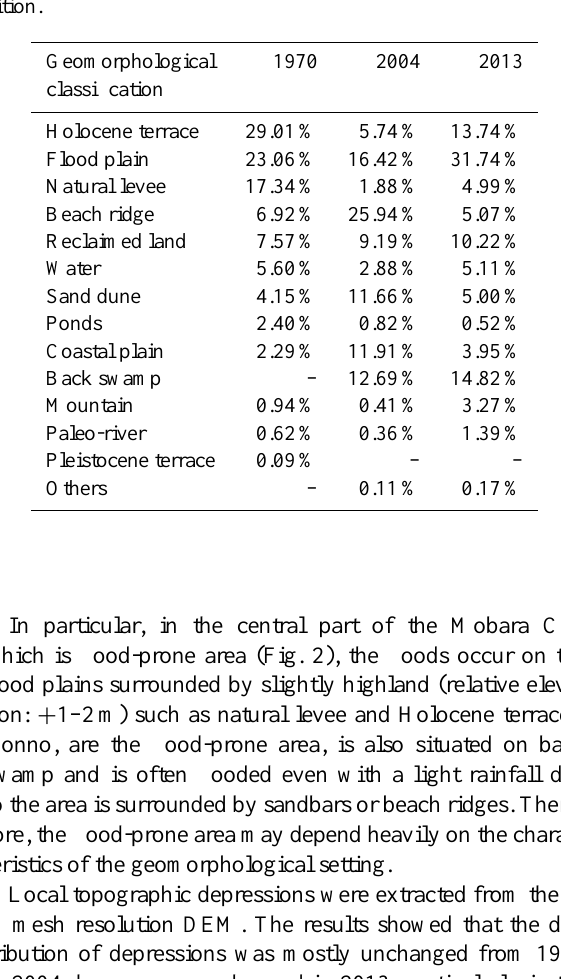
Table 2. Impermeable area ratios in each land